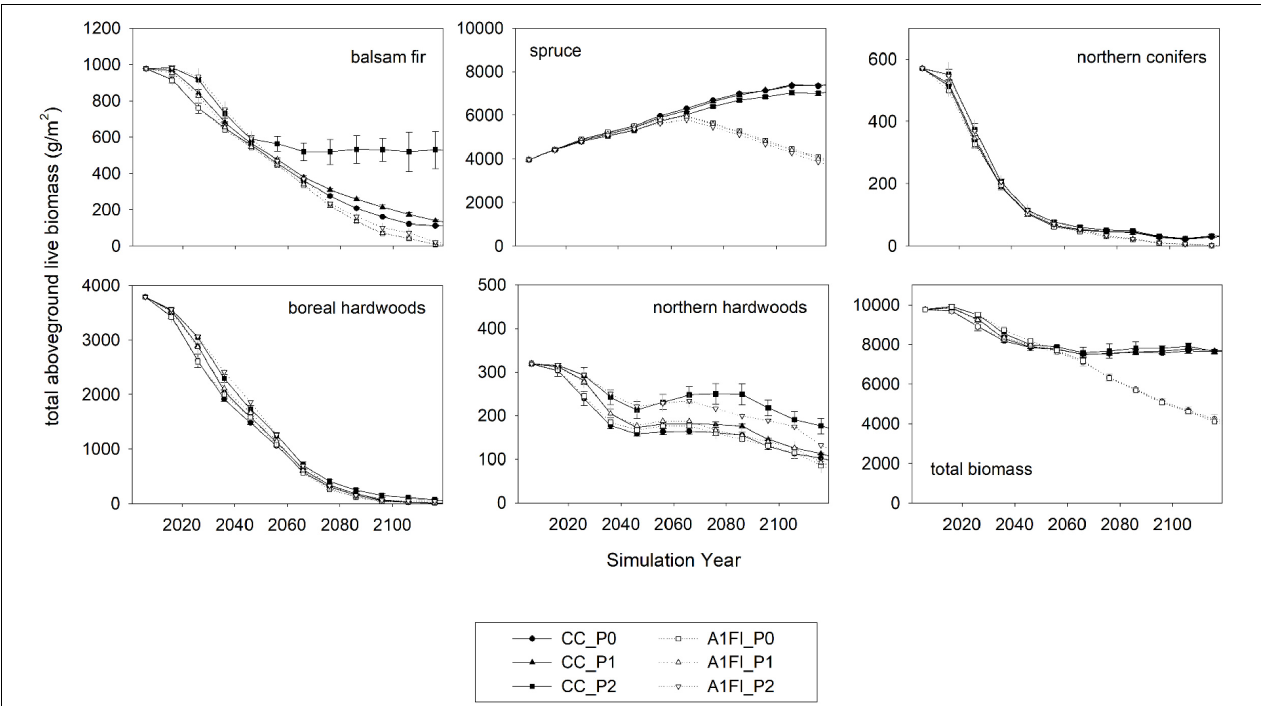
FIGURE 5 | Mean ( ± 2 standard deviations) total aboveground live biomass of three replicate simulations at 10-year intervals for 120 years of current climate and no predation (CC_P0), current climate and weak predation (CC_P1), high emissions and no predation (A1FI_P0), high emissions and weak predation (A1FI_P1) current climate and strong predation (CC_P2), and high emissions and strong predation (A1FI_P2). See methods for species included in each grouping. In some cases some scenarios overlap each other and are therefore not visible (e.g., total biomass